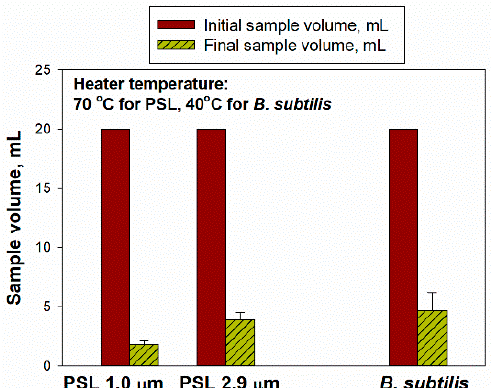
Figure 2. The initial and final volumes when concentrating the suspensions with PSL particles of two different sizes (1.0 and 2.9 μ m, with 1% solids in suspension) and B. subtilis bacterial cells (1.06 × 10 8 – 1.24 × 10 8 #/mL) using the BioChromato evaporator for 120 min. The data are averages of three repeats, and the error bars represent one standard deviation.